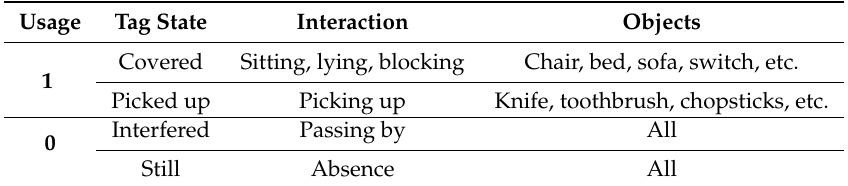
Table 1. Object-usage detection via interaction.